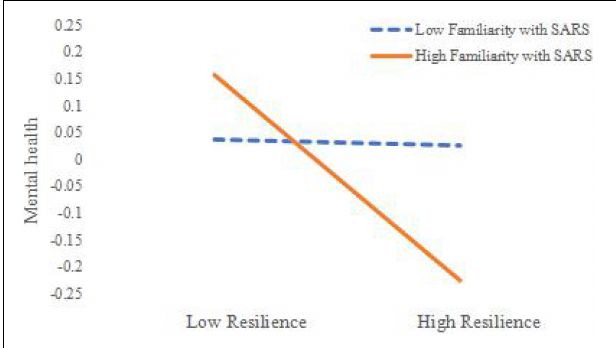
FIGURE 1 | Moderating effect of familiarity with severe acute respiratory syndrome (SARS) on the relationship between resilience and mental